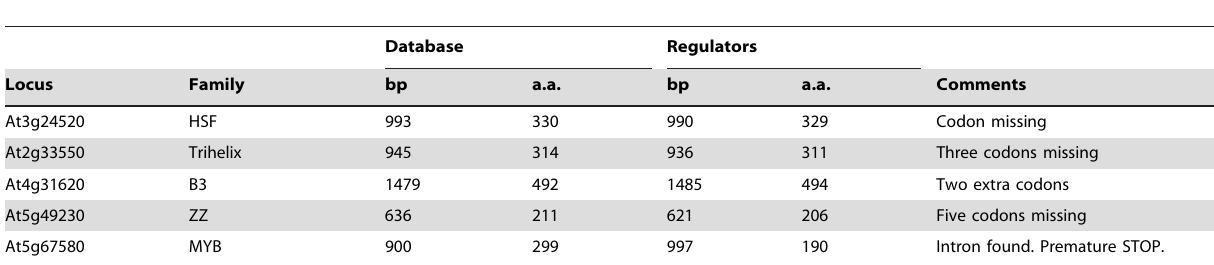
Table 1. ORFs showing differences with their corresponding sequences present in databases.